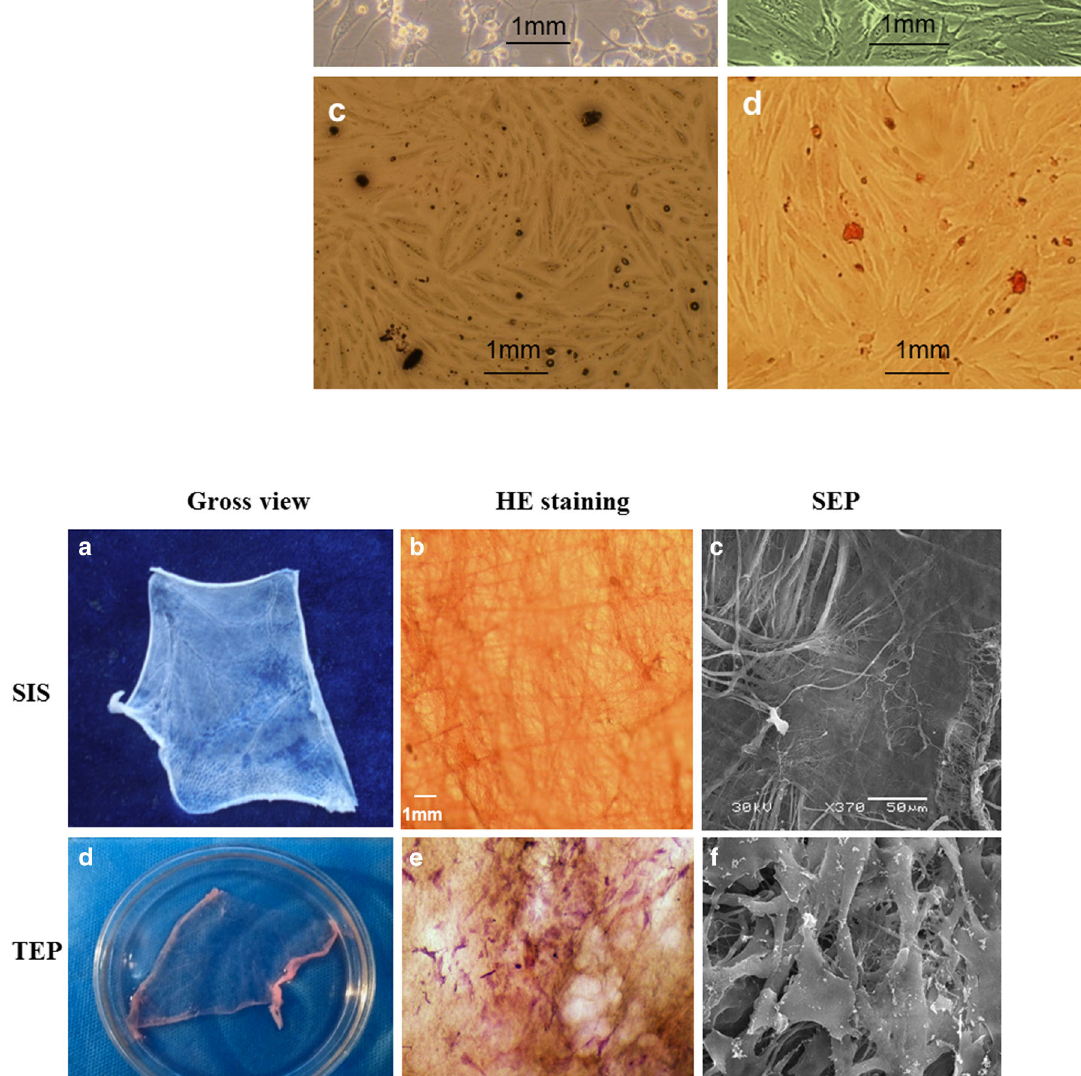
Fig. 2 Morphological investigation of the primary MSCs ( a ), osteogenically induced MSCs ( b ), AKP staining ( c ) and Alizarin Red staining ( d ) under light microscopy